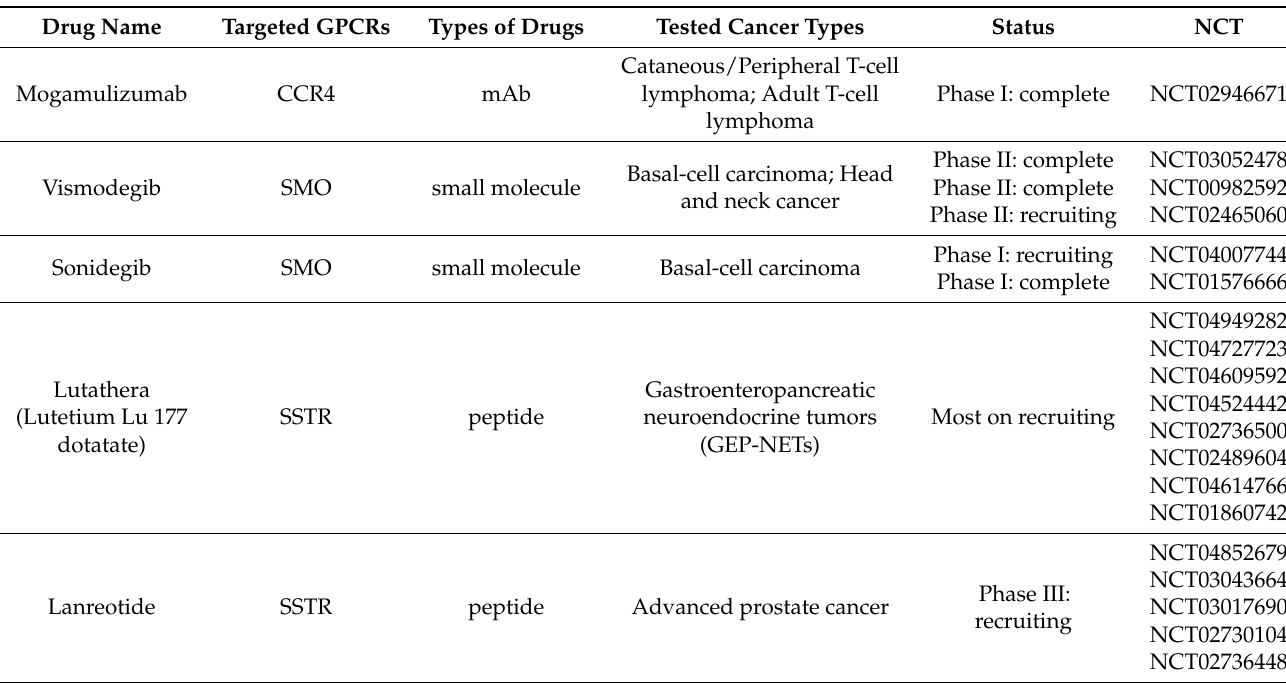
Table 3. Drugs and antibodies against GPCRs in GC clinical trials